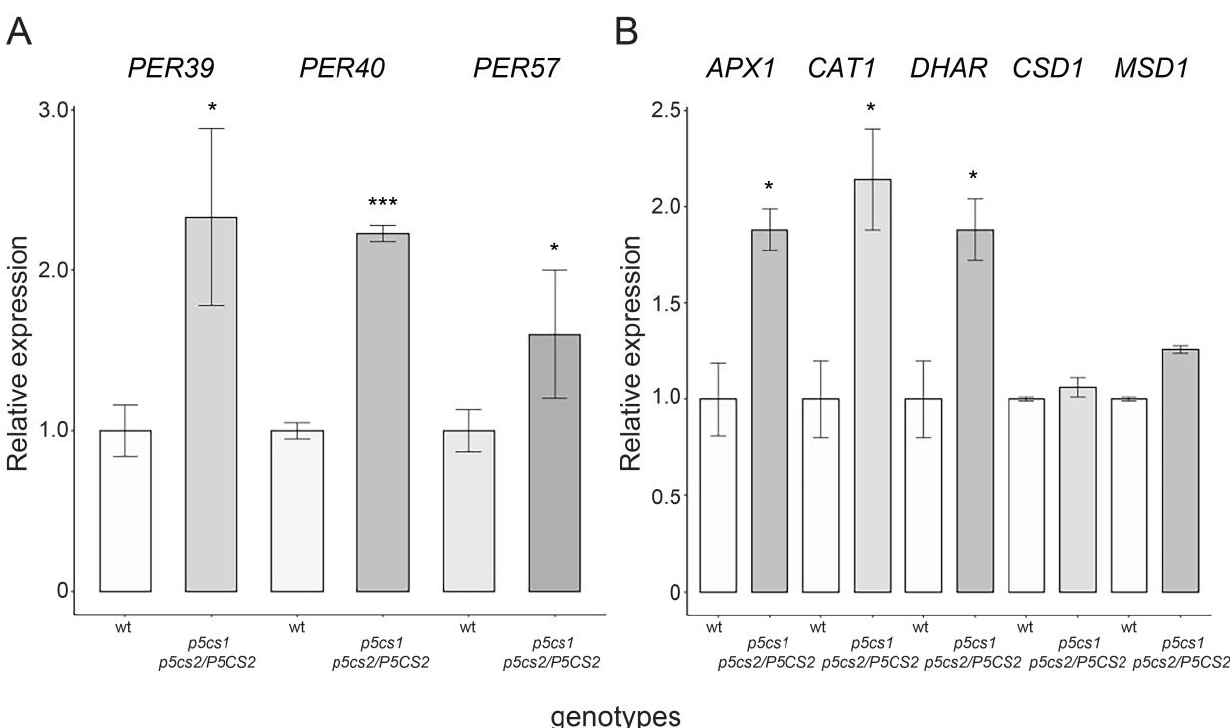
Figure 9. Expression of genes encoding antioxidant enzymes in the root meristem of proline mutants. RT-qPCR was performed on cDNA from apical root portions. The analysis shows upregulation of genes coding for antioxidant enzymes in roots from p5cs1 p5cs2/P5CS2 mutants relative to wildtype. In ( A ), a significant upregulation of PER39 , PER40, and PER57 is shown. In ( B ), the genes APX1 , CAT1 , and DHAR are significantly upregulated. The meristem-specific gene RCH1 was used as reference control to normalize the RT-qPCR. Error bars indicate Standard Deviation (SD). The Welch Two Sample t-test (wild type vs. mutant lines) was used to assess statistical significance (*** p < 0.001; * p < 0.05). The data represent the means ± SD of four independent experiments and three technical replicates per experiment.